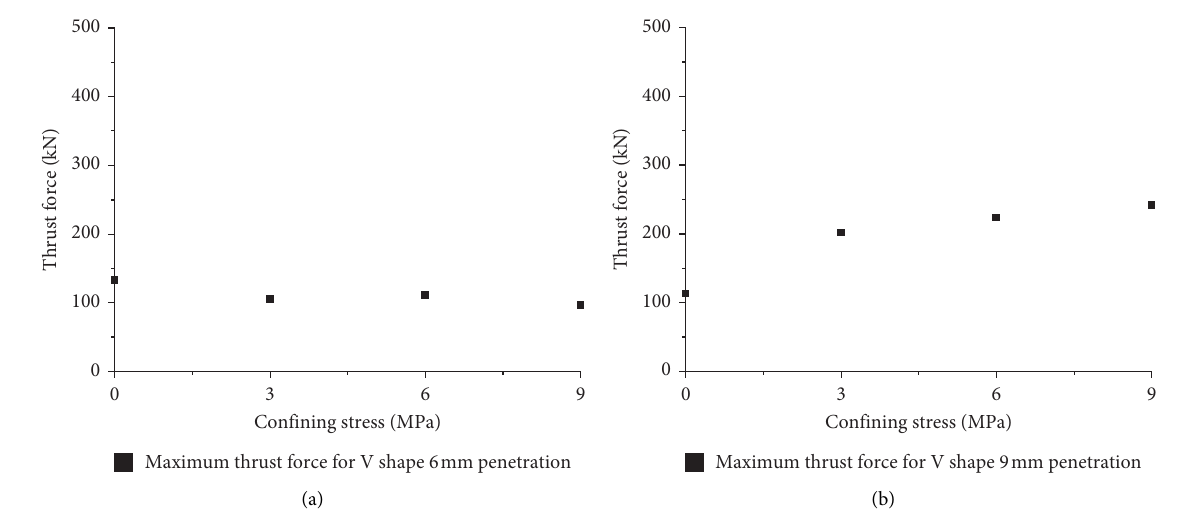
Figure 11: Maximum thrust force for the V shape disc cutter. (a) Ultimate penetration � 6 mm; (b) ultimate penetration �